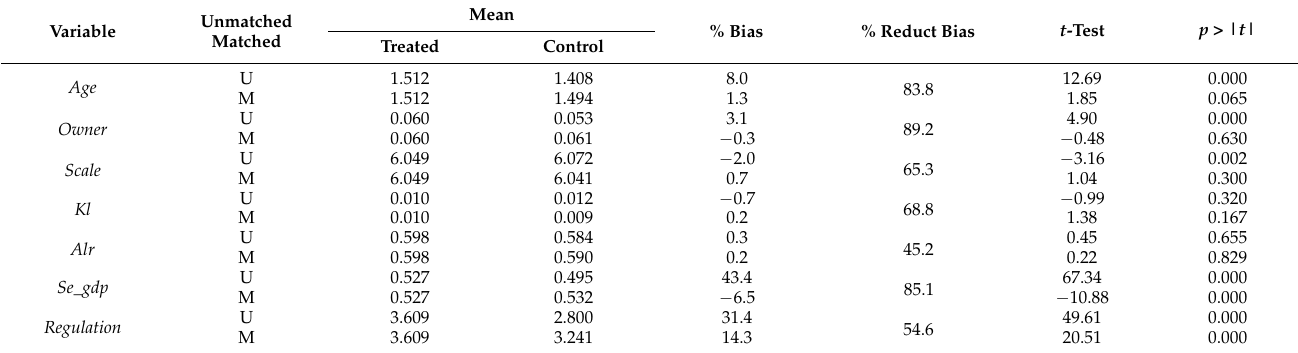
Table A2. Results of kernel matching balance test for propensity scores.